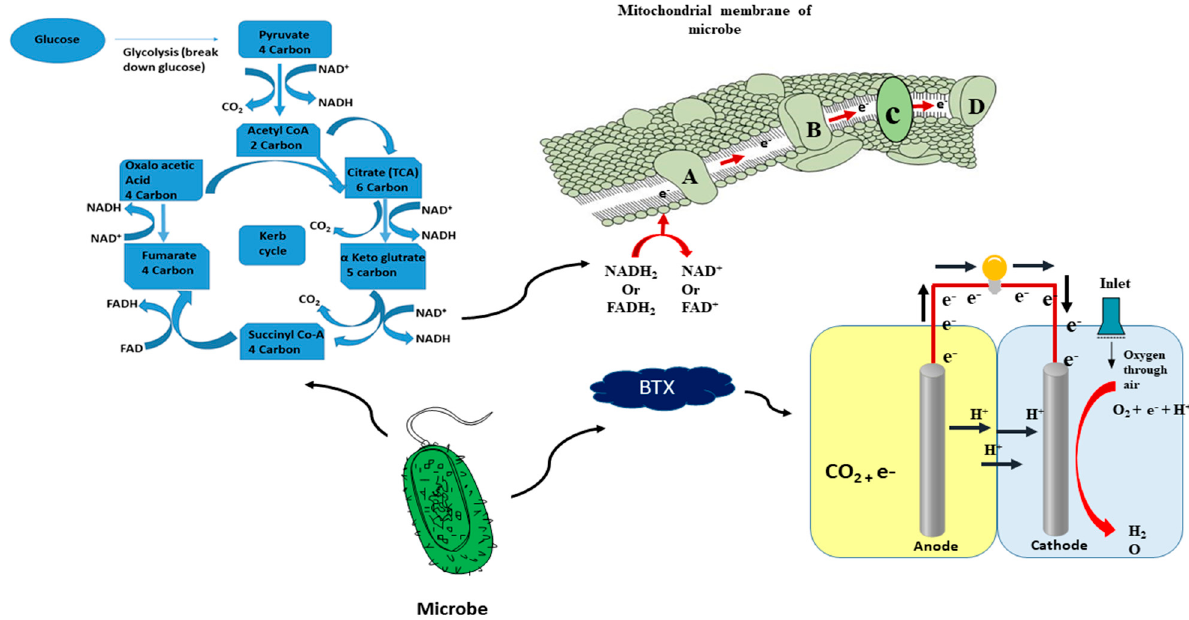
Figure 4. Glucose metabolic pathway and mechanism inside cell membrane of microbes through proteins from electron carriers (NADH and FADH) toward electrode: Proteins (A; NADH dehydrogenase, B; ubiquinone, C; coenzyme, D; cy- tochromes).